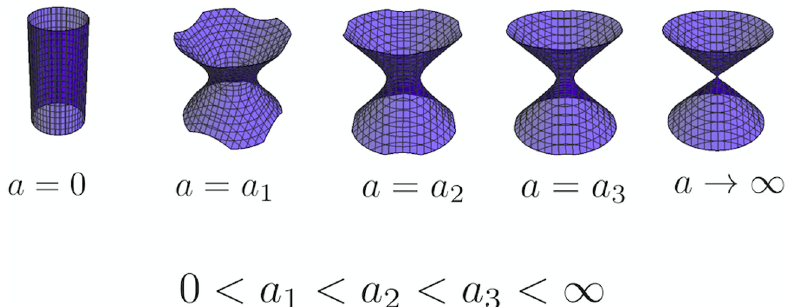
Figure 1 . Illustration of how the string worldsheet deforms gradually under increasing acceleration. We represent accelerated worldsheets as hyperboloids, which are a natural generalization of Rindler particle